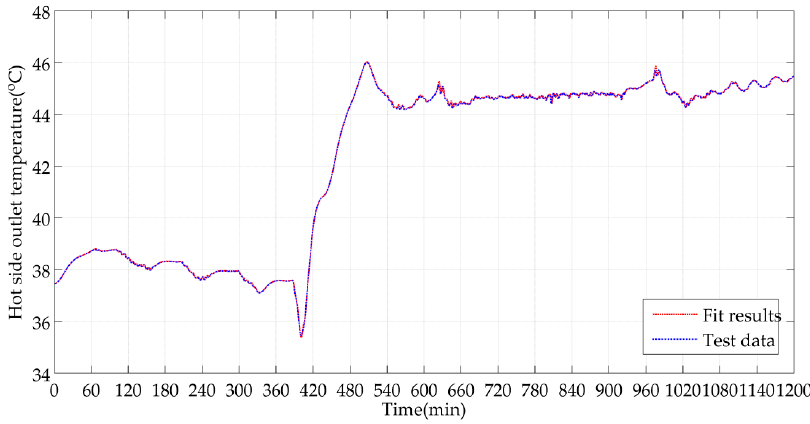
Energies 2017 , 10 , 1398 Figure 4. Fit results of hot side outlet temperature by grey-box method. Figure 4. Fit results of hot side outlet temperature by grey-box method.